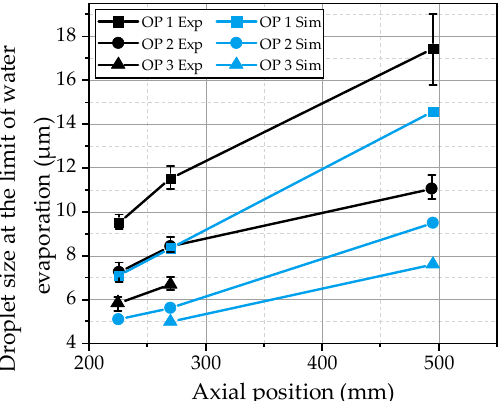
Figure 17. Droplet size at the limit of water evaporation as a function of the axial distance from the nozzle for the three investigated operating points.